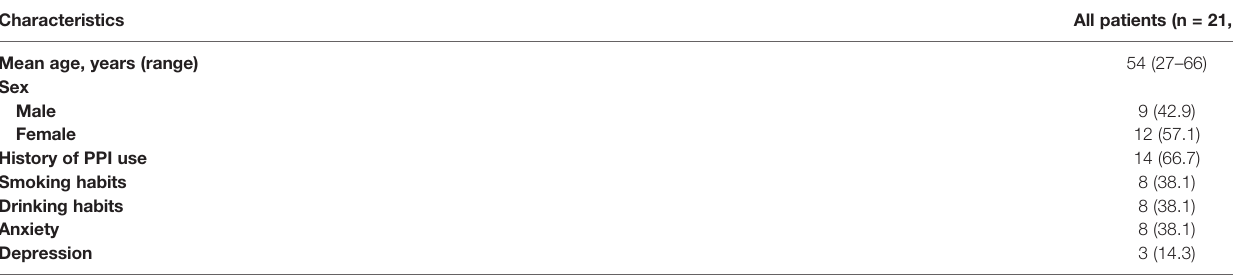
TABLE 1 | Patient demographics and clinical features in this study. Characteristics